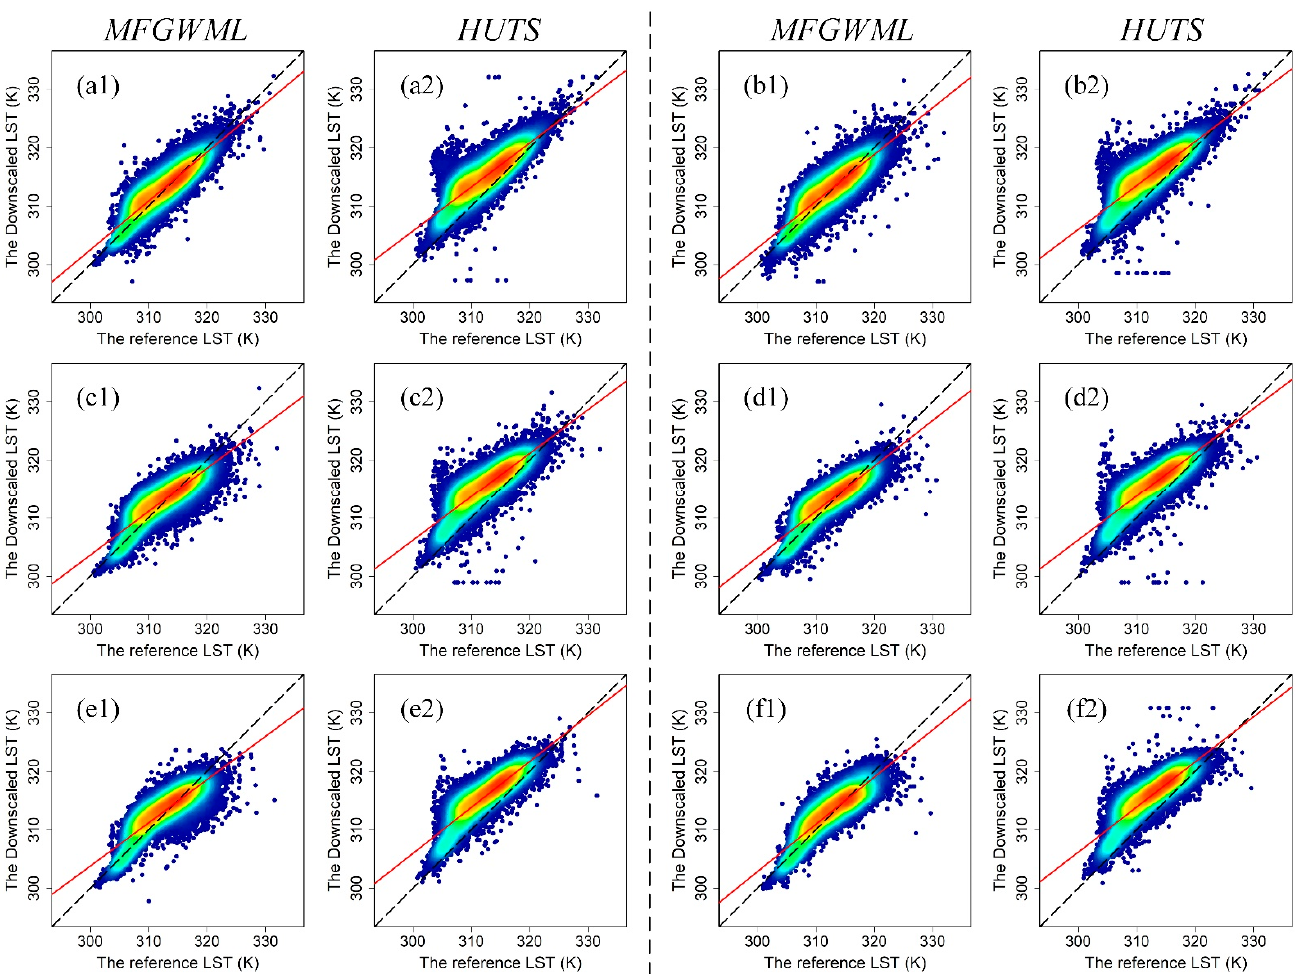
Figure 12. Density scatterplots of per-pixel comparison between the downscaled LST (K) data ( Y -axis) and the reference LST (K) data ( X -axis) at different scales ( a1 , a2 , b1 , b2 , c1 , c2 , d1 , d2 , e1 , e2 , f1 , f2 ). Plots ( a1 , a2 ) are the density scatterplots for Scheme 1, which corresponds to the MFGWML and HUTS models, respectively. The remainder of the plots are named in the same manner. The dotted black line is the 1:1 reference line, and the solid red line is the fitting line. Table 10. Statistical parameters for the fitting lines of scatters in MFGWML and HUTS for the six downscaling schemes performed around the central urban area.